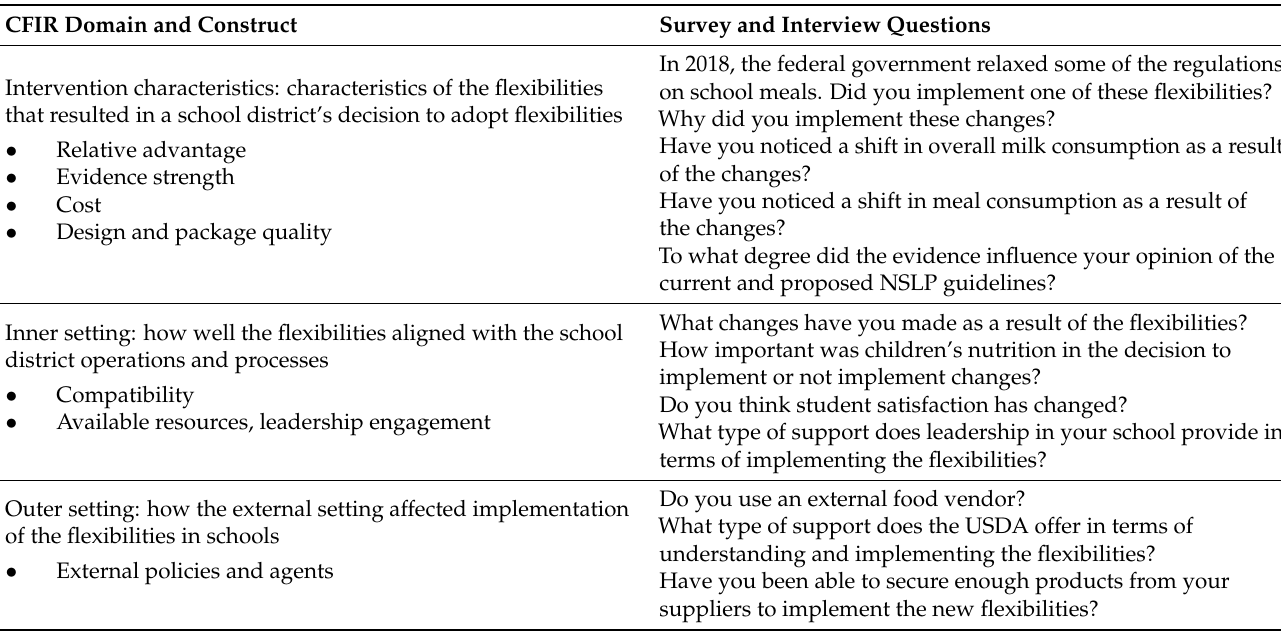
Table 1. Description of Consolidated Framework of Implementation Research constructs used in survey and interviews.